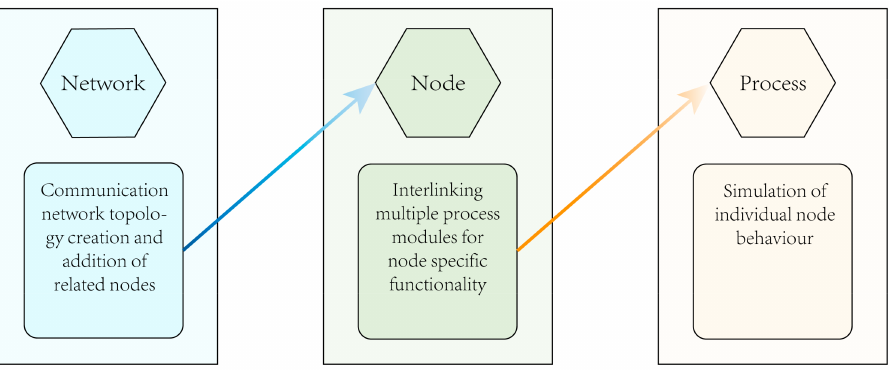
Figure 7. OPNET three-layer modelling